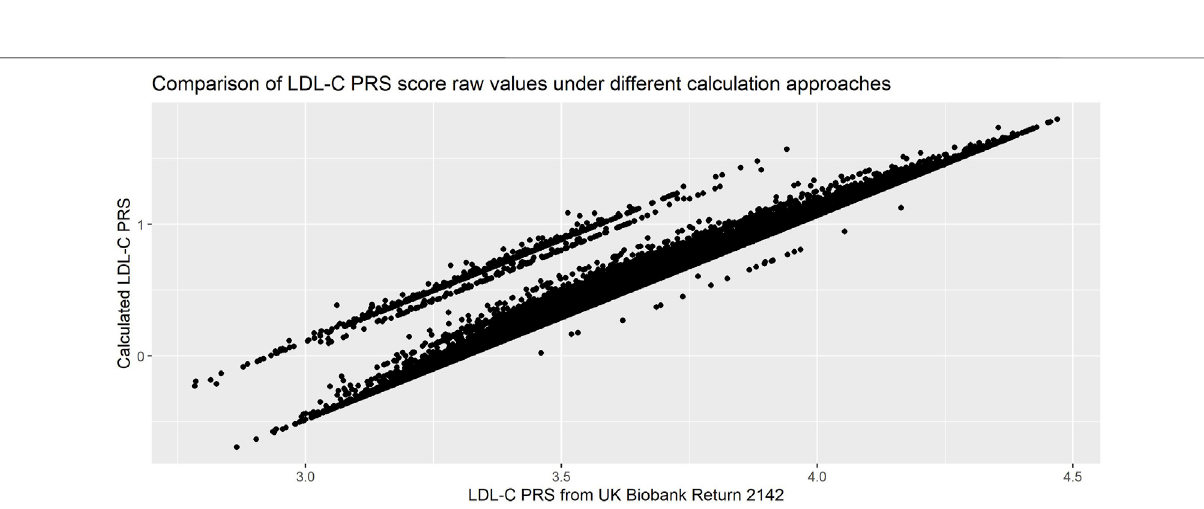
Frontiers in Genetics |